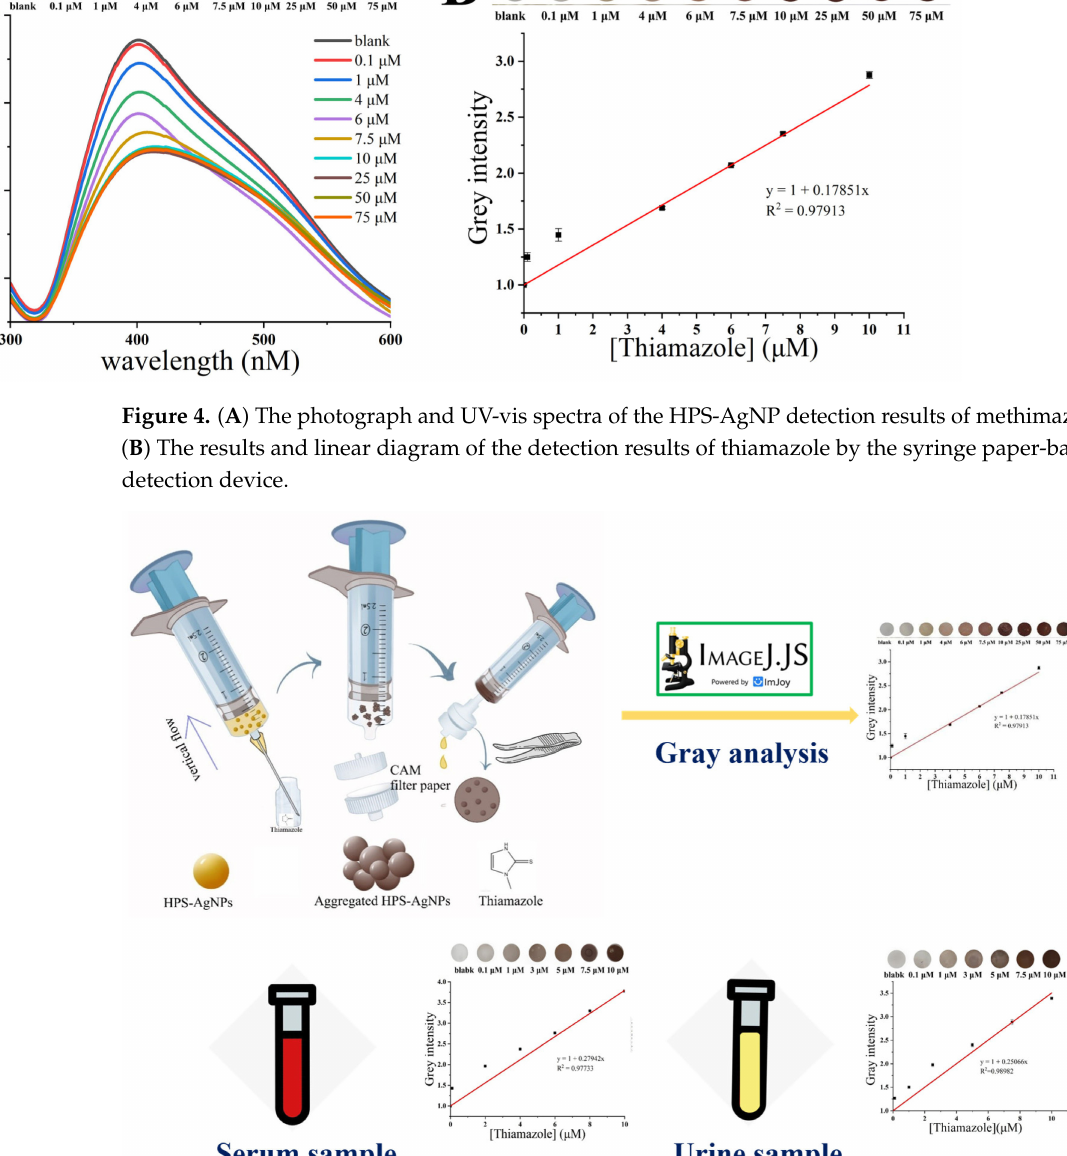
Figure 5. The flow diagram of the experimental activities of the syringe paper-based detection device and detection